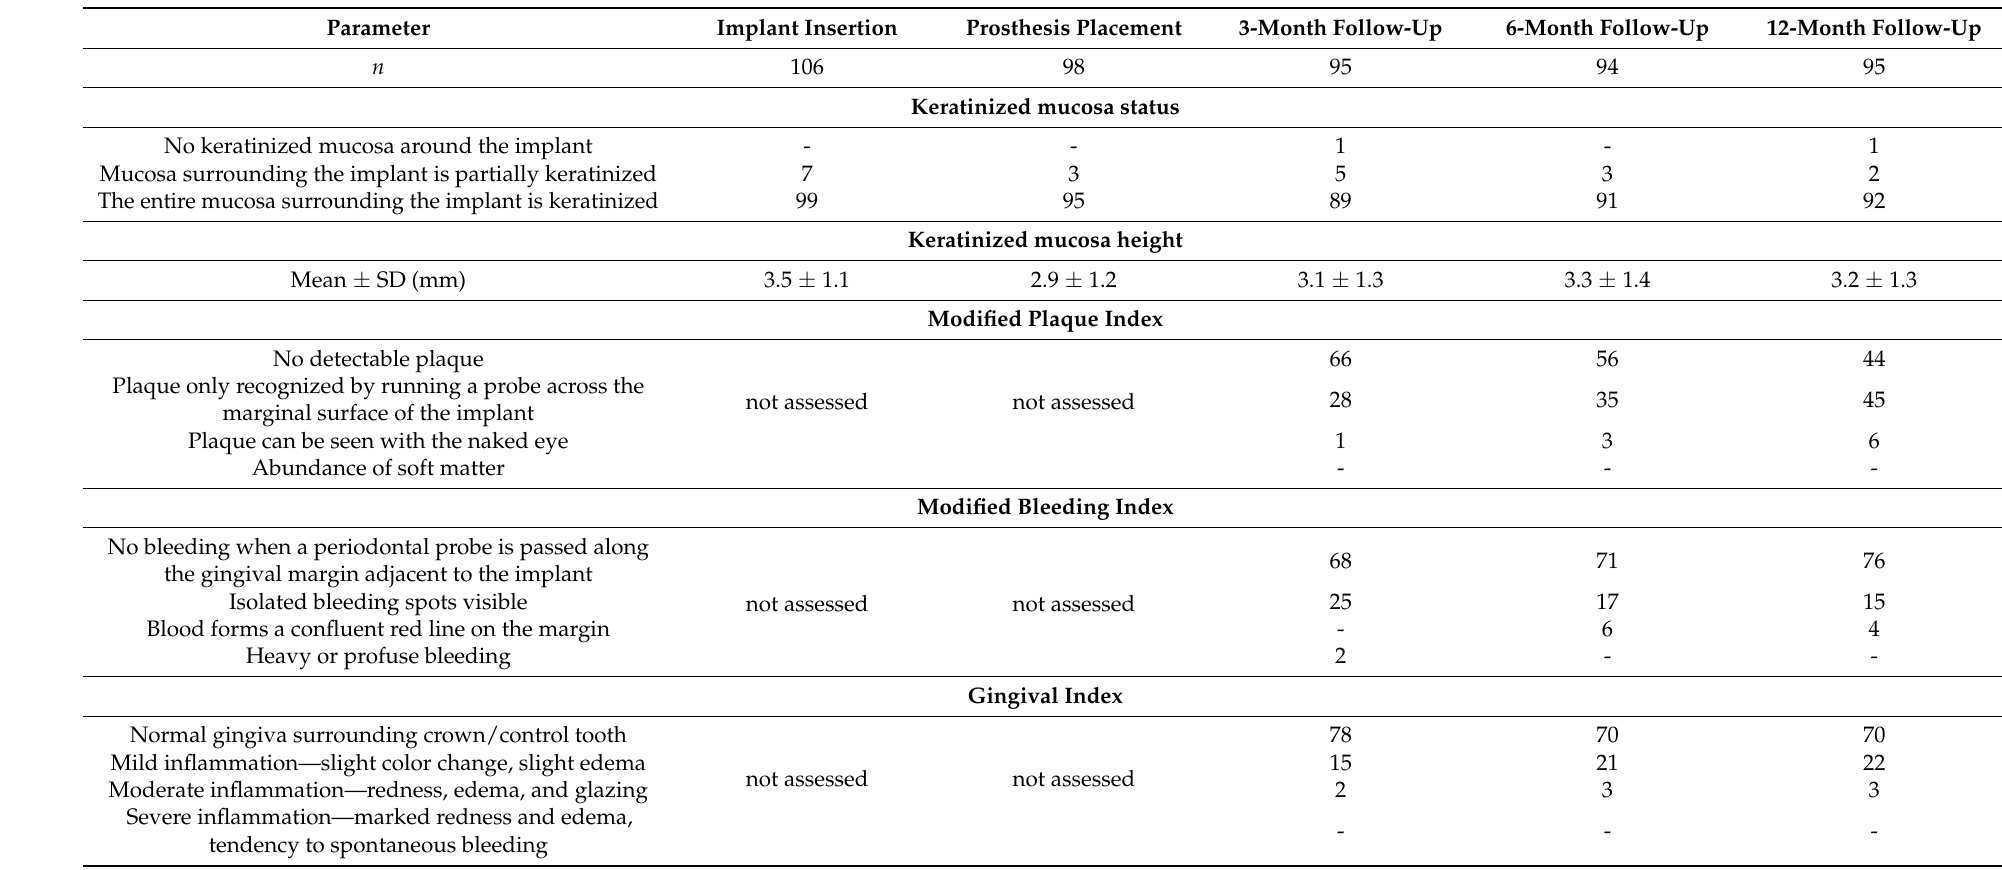
Table 2. Soft tissue health throughout the